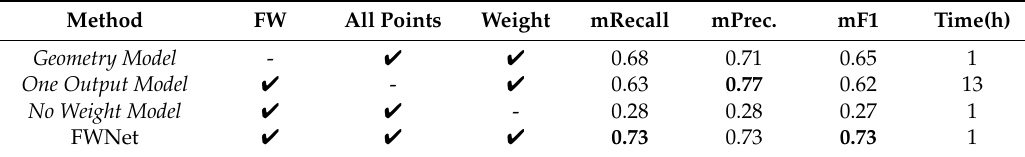
Table 3. Ablation study on di ff erent components of our proposed method. The metrics in this table, recall (mRecall), precision (mPrec.), and F1 score (mF1), are the mean values. The boldface text indicates the best performance. The Time indicates the time required to predict the test